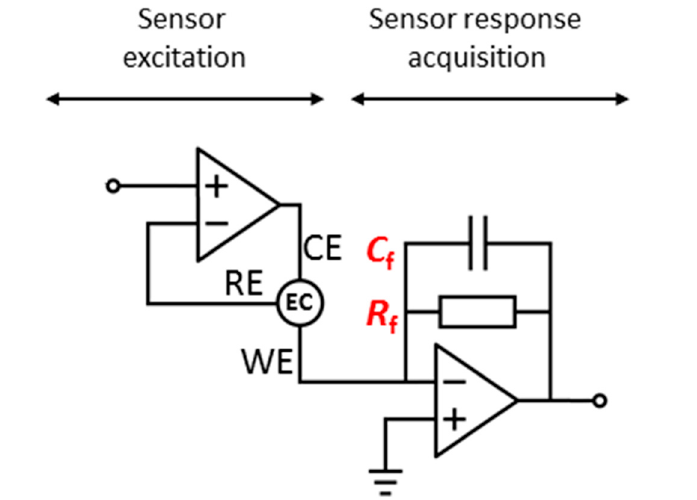
Figure 1. Electronic schematic of the two core parts of the potentiostat: the sensor excitation stage including the three-lead approach and an electrochemical cell (EC), and the inverter sensor response acquisition stage, with the feedback capacitor and resistor, to transform the sensor response current to a measurable